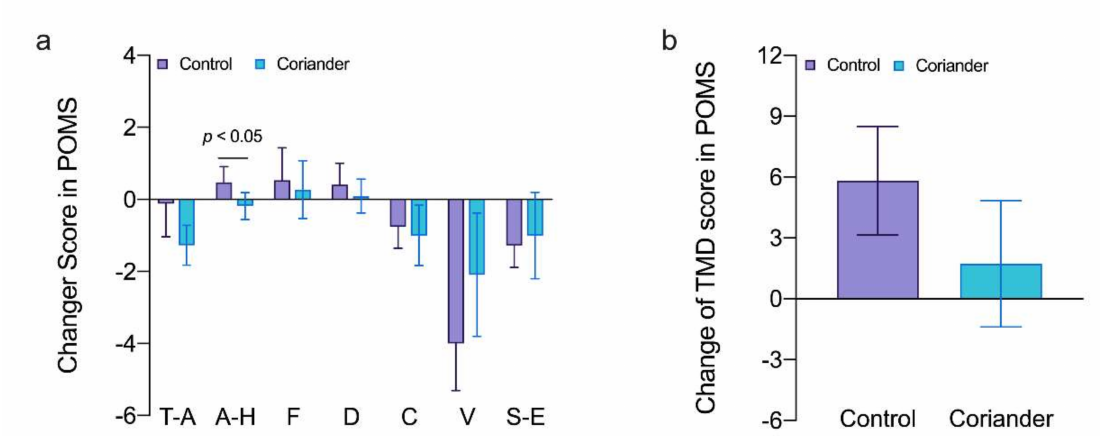
Figure 2. ( a ) Subscale scores for the profile of mood states (POMS) scale in the coriander and control groups (means ± SD). T-A, tension-anxiety; A-H, anger-hostility; F, fatigue; D, dejection; C, confusion; V, vigor; S-E, self-esteem; ( b ) Comparison of the total mood disturbance (TMD) in the profile of mood state (POMS) questionnaire in the two groups. Data are presented as variation ± standard error ( n = 13). Independent t -tests were used to identify the significant differences between the two